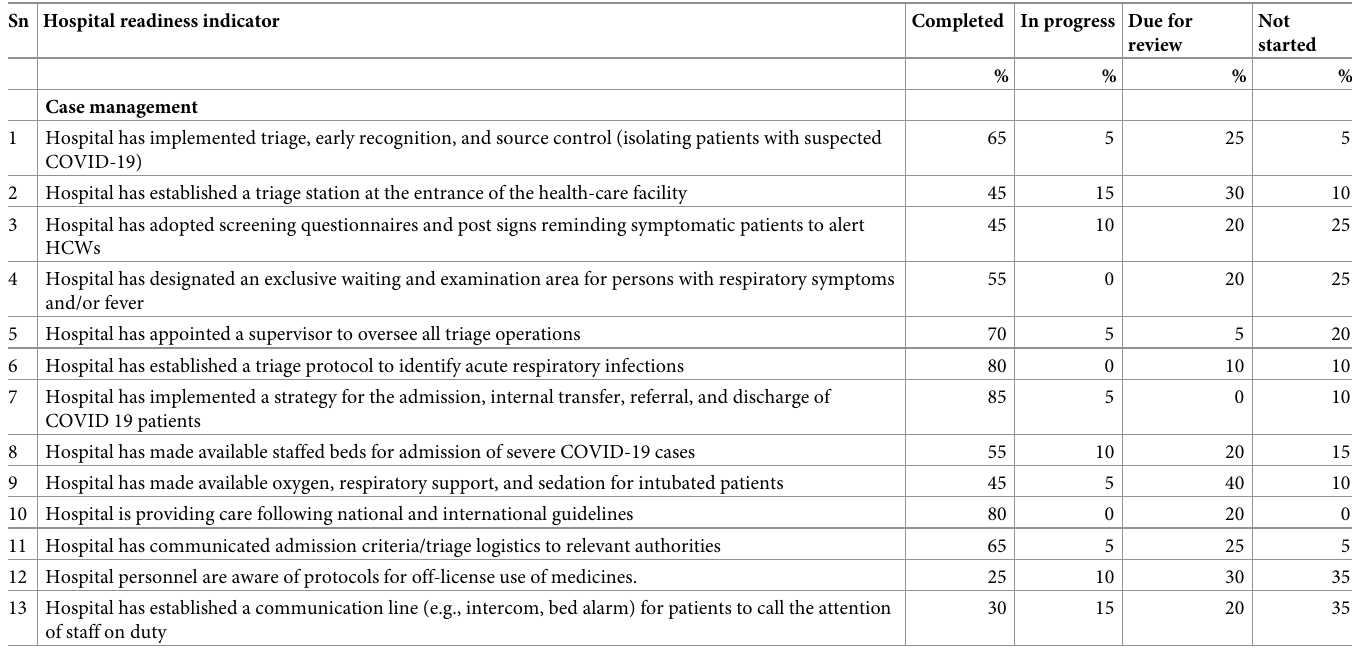
Table 5. Implementation of COVID-19 case management readiness indicators among 20 hospitals in Nigeria. Sn Hospital readiness indicator